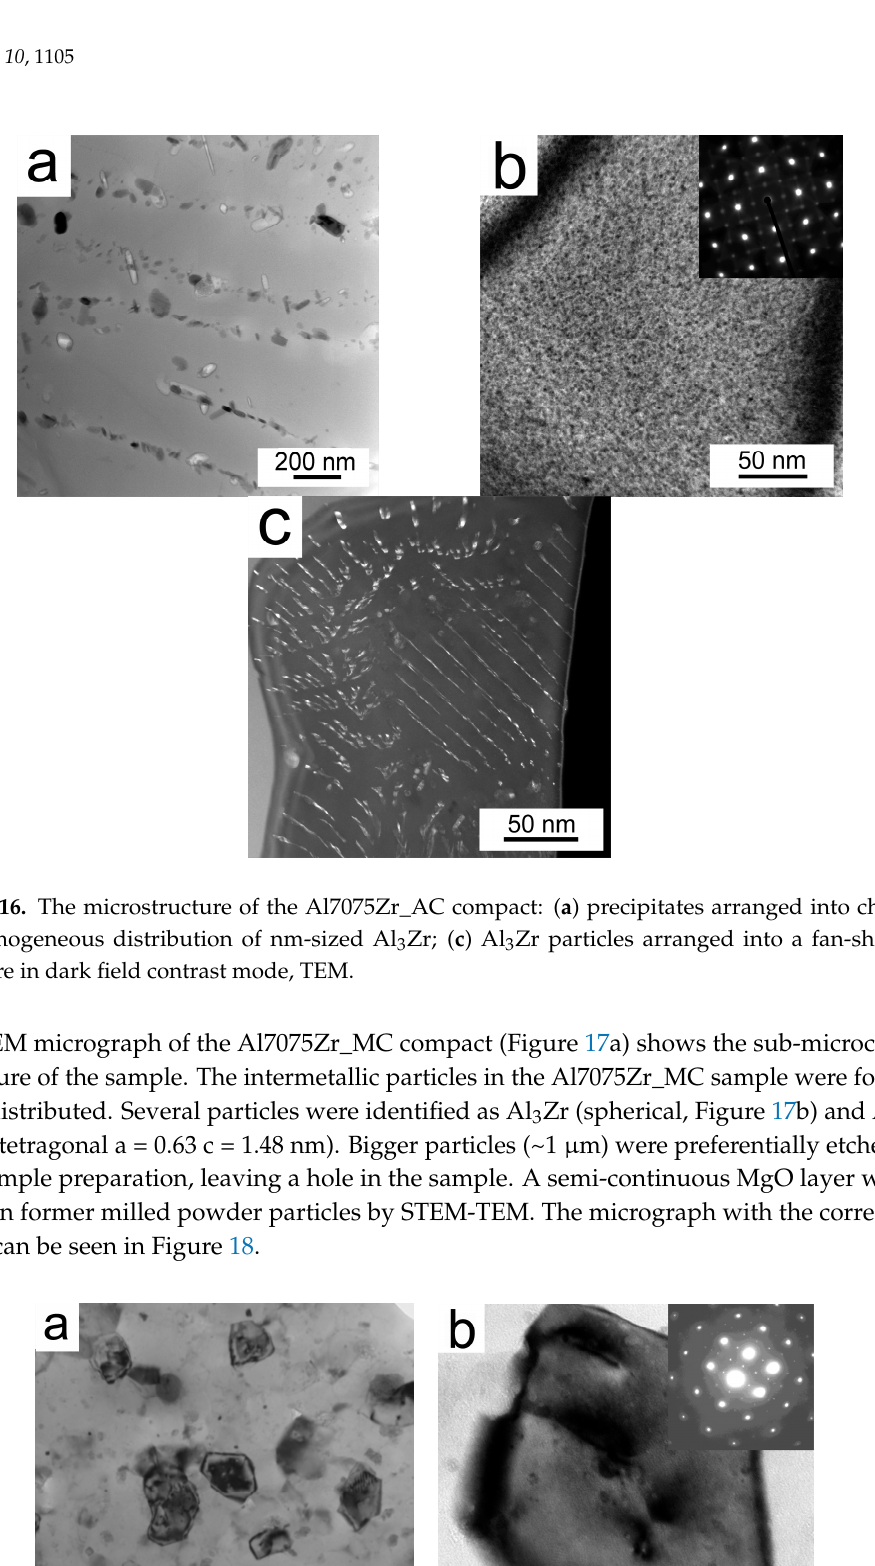
Figure 17. The microstructure of the Al7075Zr_MC compact: ( a ) the sub-microcrystalline microstructure of the sample; ( b ) a grain containing Al 3 Zr particles, TEM.